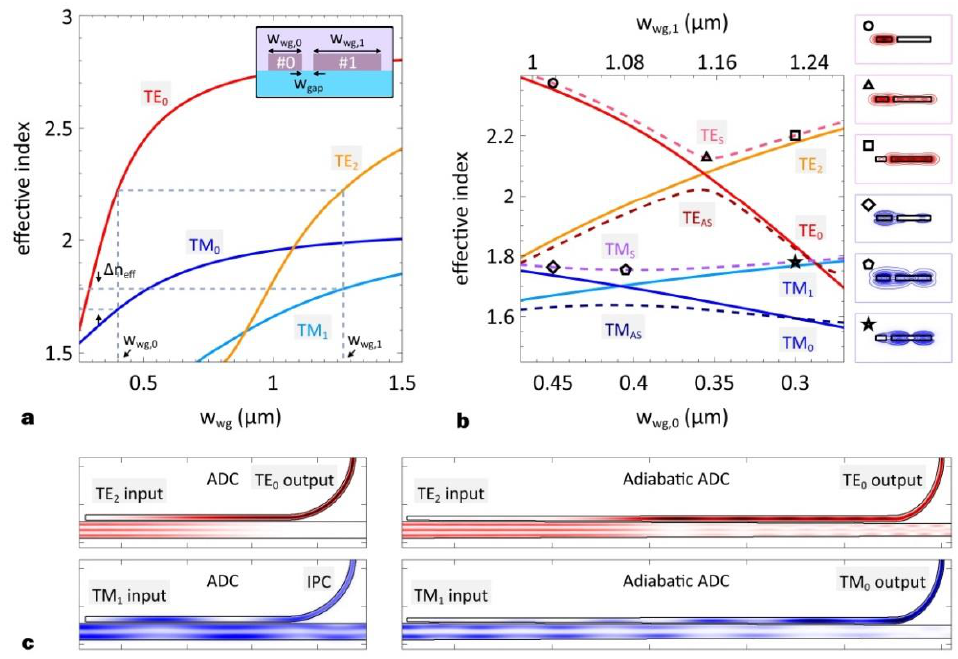
Figure 8. ( a ) The calculated e ff ective indices for TE 0 / TE 2 / TM 0 / TM 1 modes in the SOI waveguide with varied waveguide width (w wg ). The inset shows the cross-section of an ADC with some key parameters labeled. ( b ) The calculated e ff ective indices for TE 0 / TE 2 / TM 0 / TM 1 modes (solid lines) and TE S / TE AS / TM S / TM AS super-modes (dashed lines) in the ADC as the waveguide width (w wg,0 and w wg,1 ) varying. The inset shows the mode profiles. ( c ) The calculated light propagation profiles for ADC (left panel) and adiabatic ADC (right panel) when TE 2 and TM 1 modes are launched.